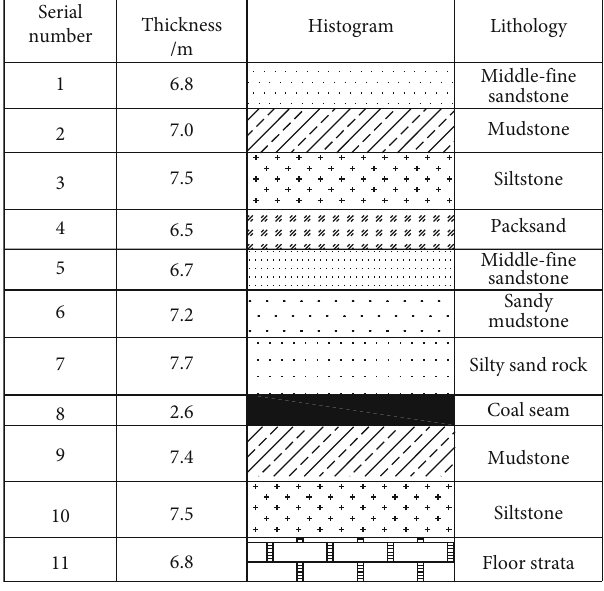
Figure 2: Columnar model of overburden rock formations in coal